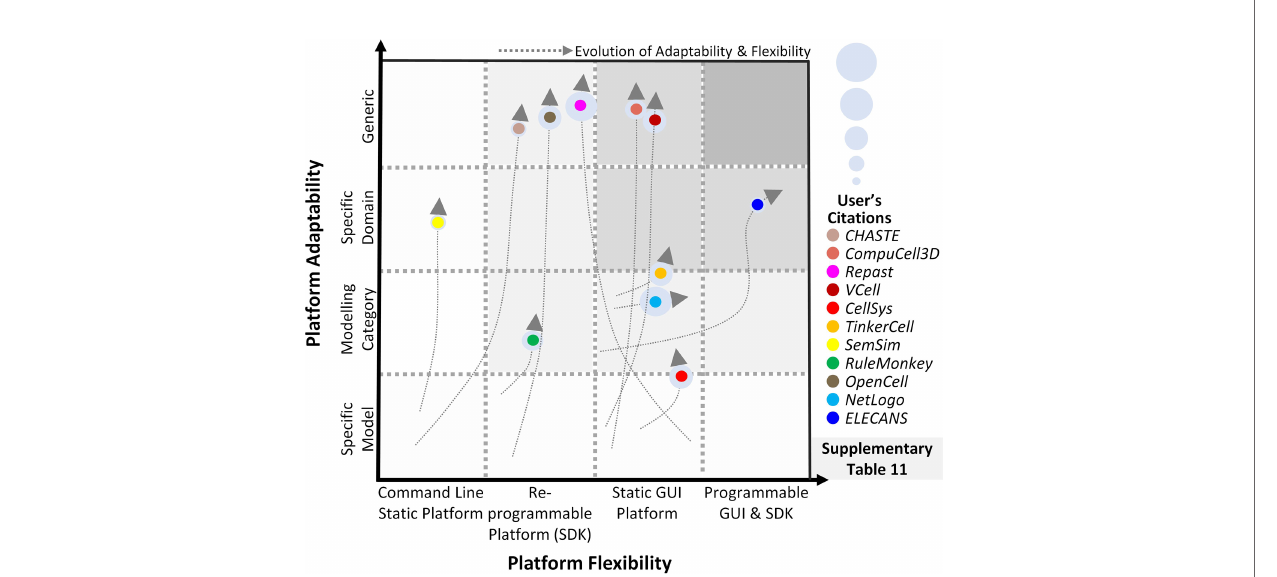
FIGURE 4 | Evolution of scale-speci fi c and multi-scale software. Evolution of multi-scale modeling software for abstracting and simulating the spatiotemporal biomolecular complexity. Highlighting the need for a generic, data-driven, zero-code software